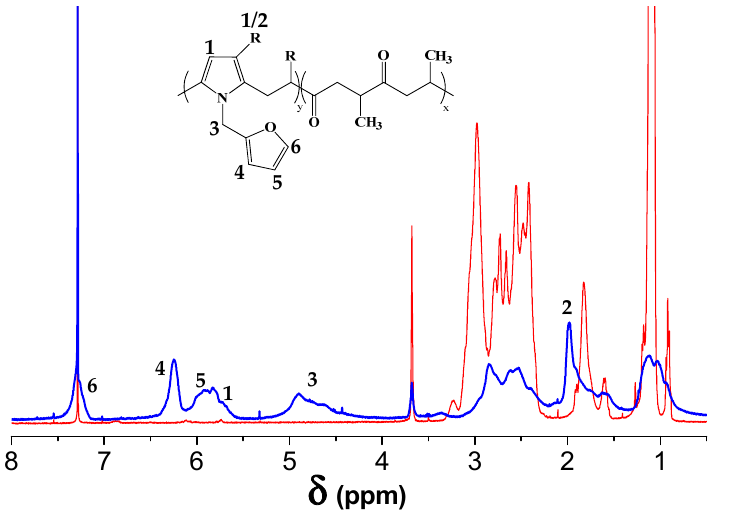
Figure 3. 1 H-NMR spectrum of the pristine polymer (PK) and of the polyketone modified with furfurylamine (PKFU).